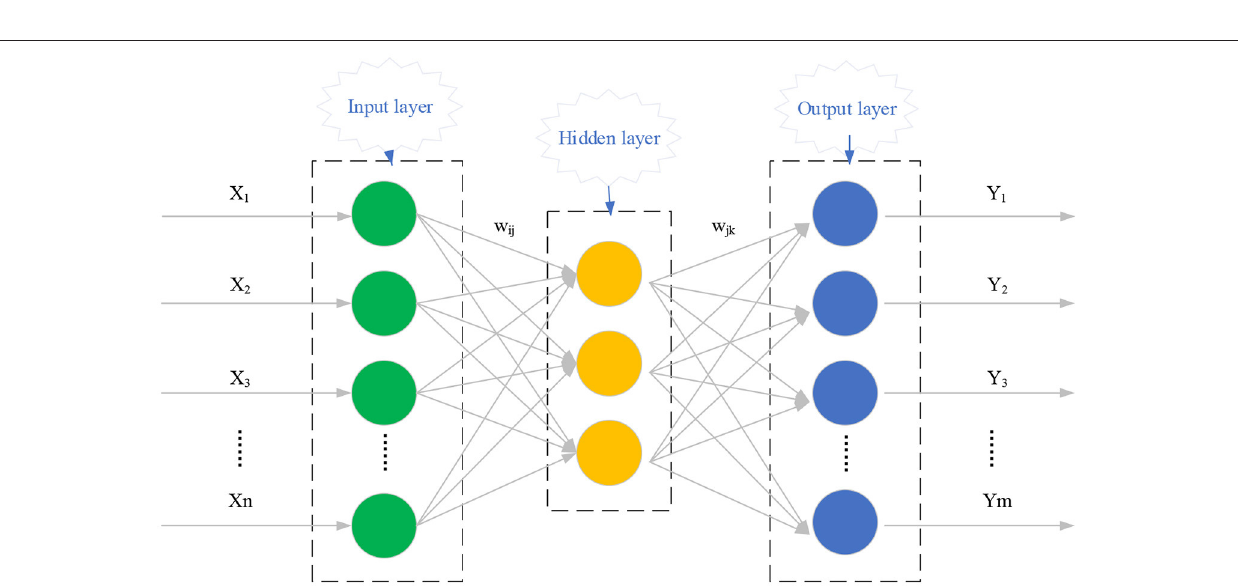
FIGURE 2 | Schematic diagram of psychological construction of dance A Couple Guarding A Sentry Box .